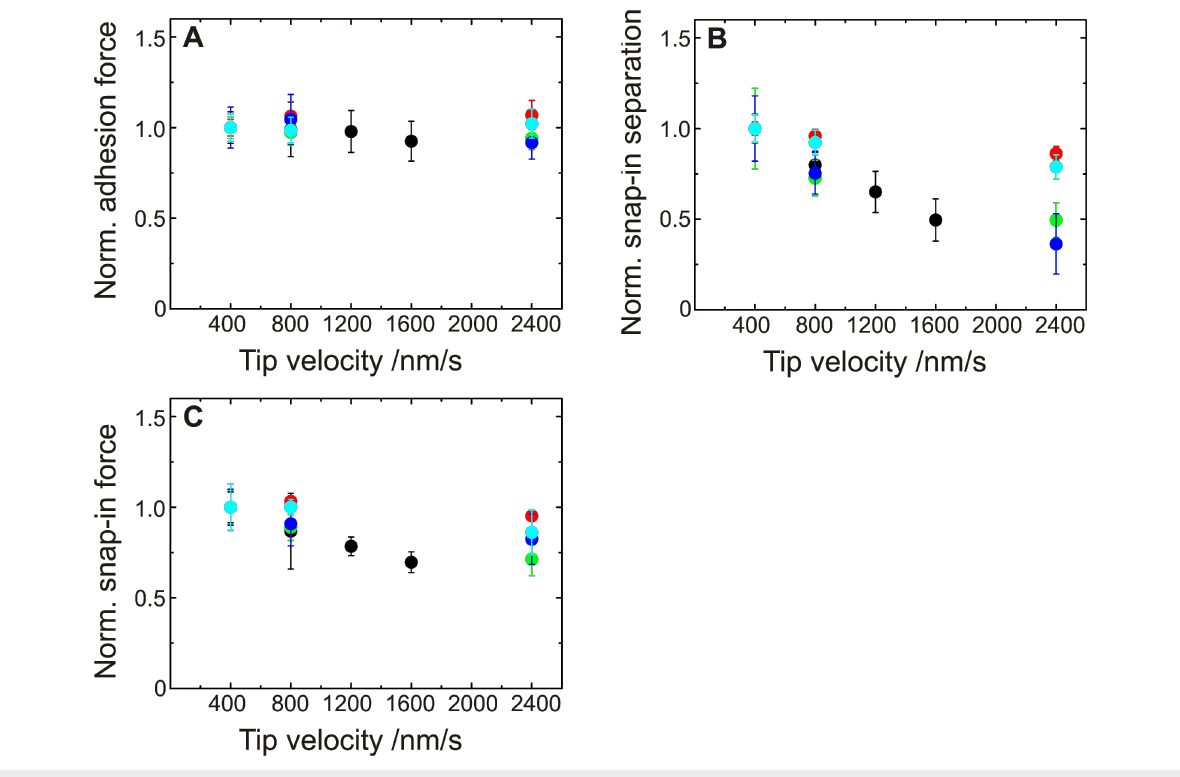
Figure 5: Influence of the tip velocity on the adhesion of S. carnosus shown for five different cells. For each bacterium, values for adhesion force (A), snap-in separation (B) and snap-in force (C) are shown. The values are normalized to the value of the measurement with the lowest tip velocity (400 nm/s). Different colors represent different bacterial